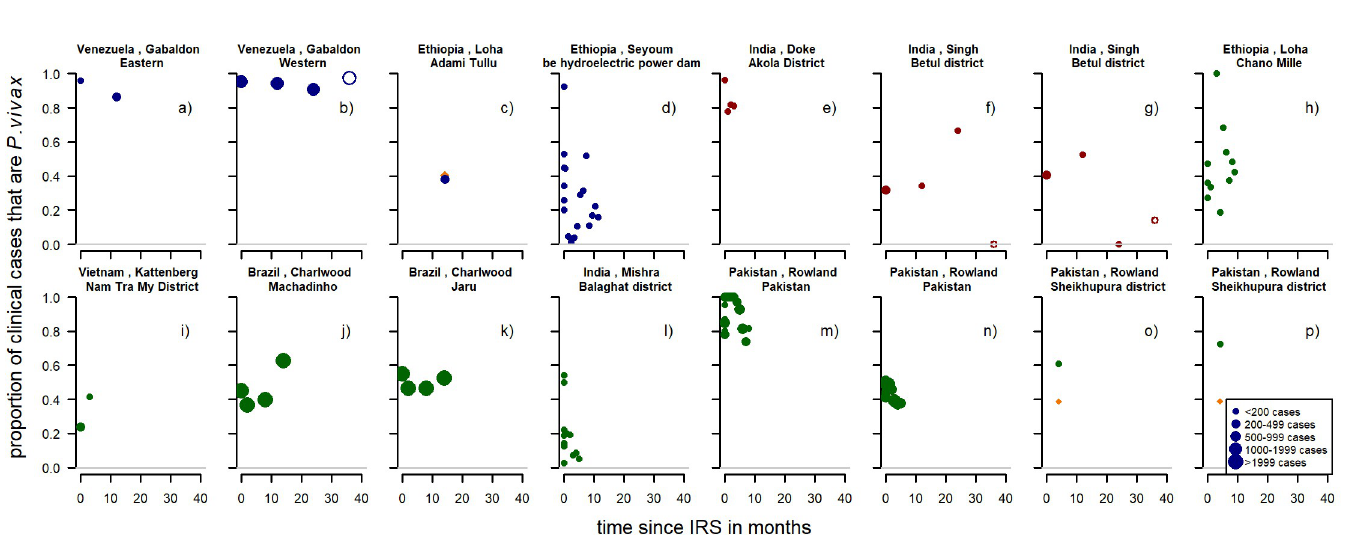
Fig 7. Proportion of clinical cases with P. vivax infection by time since IRS. Blue: first time spraying (there was no spraying for at least a year before), red: repeated spraying (spraying had occurred previously but there was a change in insecticide used), green: unclear if spraying happened before (no mention of spraying before the study but also no clear mentioning of spraying being the first time). Open circles: more than 24 months after IRS, Orange diamond shaped dots are from the control group. Dot size depending on number of cases. Pre-intervention points as described in Methods (definition of variables: time since implementation).